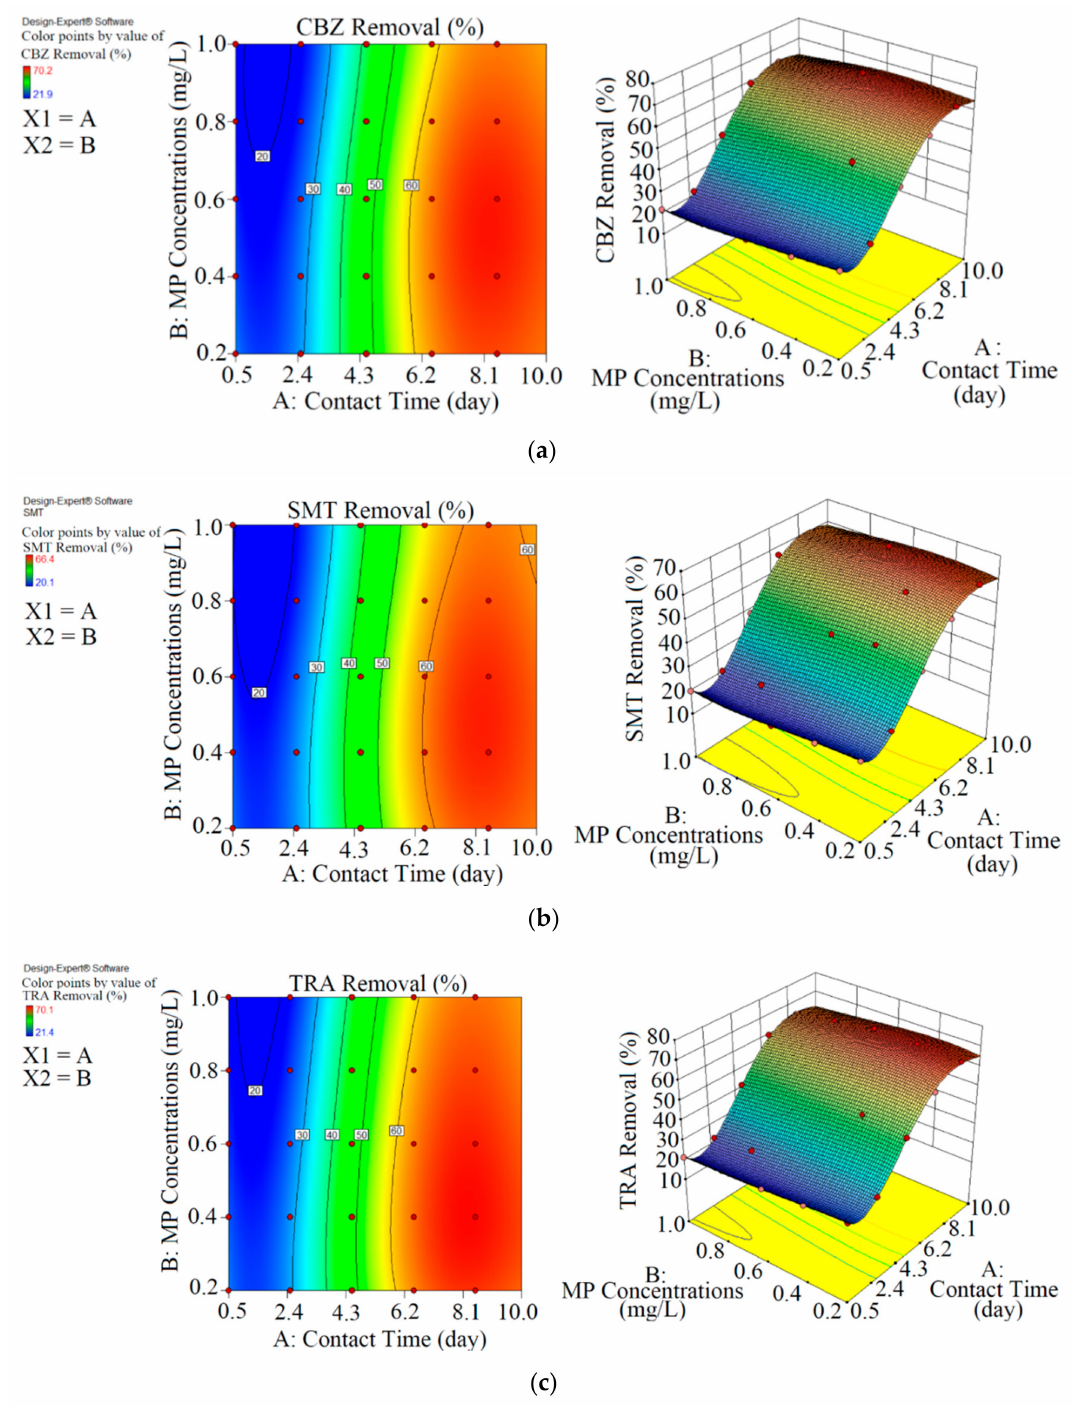
Figure 3. 3D plots for the removal of CBZ ( a ), SMT ( b ) and TRA ( c ) in the second reactor based on the